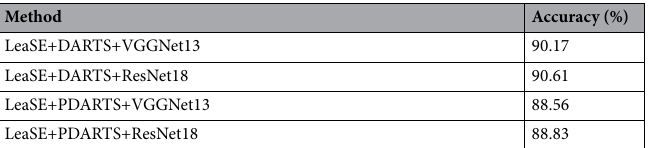
Table 5. Results on how different choices of audience models affect test accuracy. LeaSE+DARTS+VGGNet13 denotes that LeaSE is applied to DARTS with VGGNet13 as an audience model. Similar meanings hold for the rest of notations in such a format.